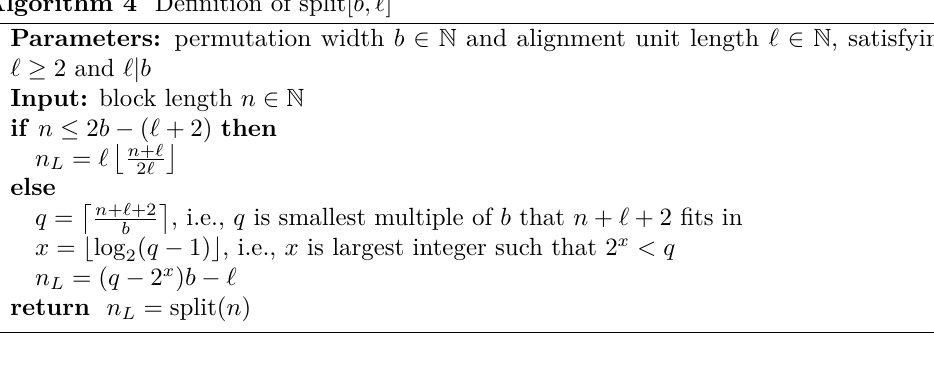
Algorithm 4 Definition of split[ b, ‘ ]